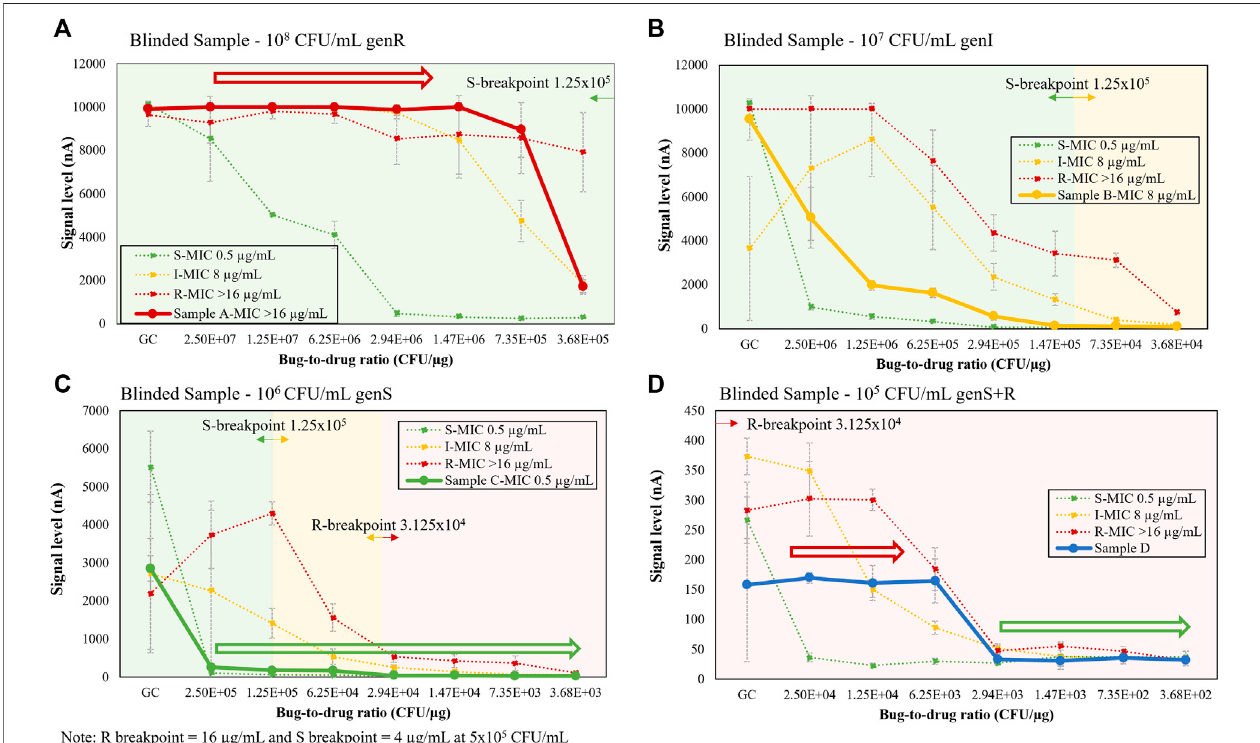
FIGURE 9 | (A – D) Single response curve for blinded samples (solid lines), including polymicrobial, S, I, and R strains, shown on top of 10 5 -10 8 CFU/mL signature response library (dotted lines) from Figure 8 . Each strain in the polymicrobial sample was contrived at 10 5 CFU/mL.